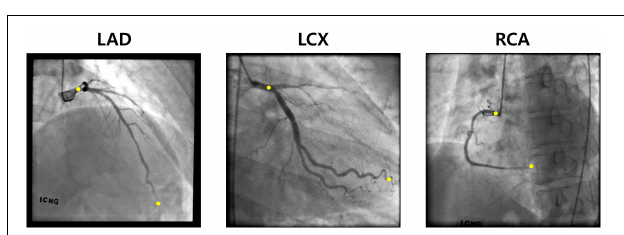
FIGURE 5 | Examples of the two ends (yellow) pointed by the deep learning network for LAD, LCX, and RCA.